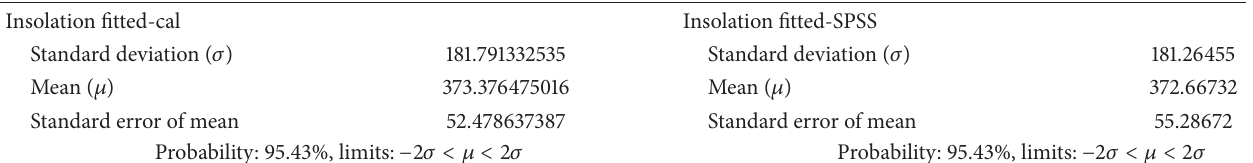
Table 7: The standard deviation, mean, standard error of mean, probability, and limits of regression equation results with the isolation level as the dependent